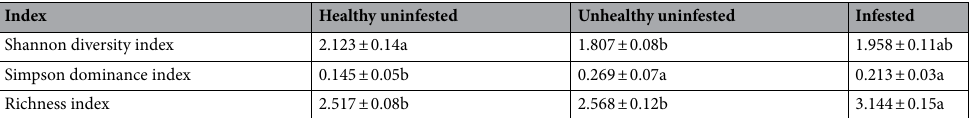
Table 3. Diversity indices of fungal communities from three tree samples. The data were analyzed by one-way ANOVA followed by HSD test. The results are expressed as the mean ± SD. The results followed by different letters are significantly different according to the HSD test (p <